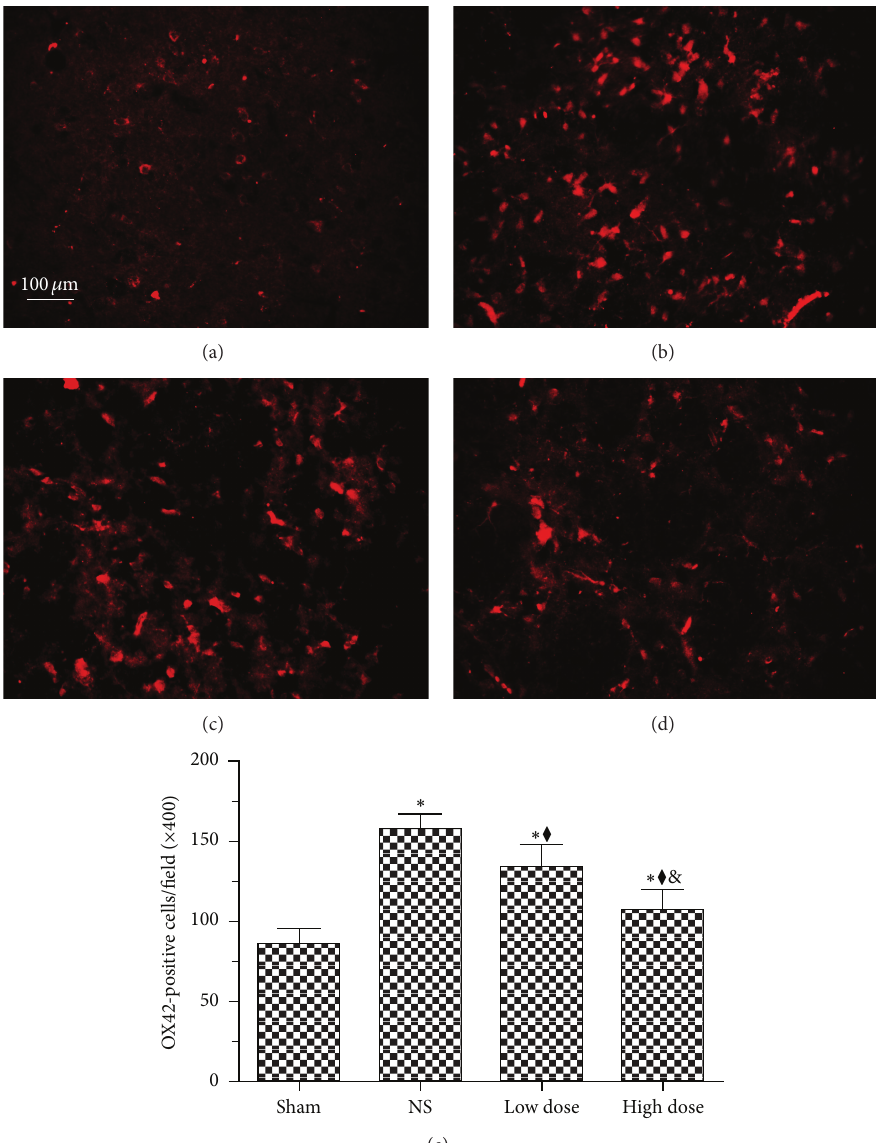
Figure 2: Scutellarin decreases the number of activated microglia in brain of hypertension. (a–d) Cluster of differentiation 11b (OX-42) immunostaining for microglia. (e) Quantification of OX-42-positive cells revealed that activated microglia were significantly increased in normal saline (NS) rats compared with the sham group, and treatment with scutellarin significantly reduced these numbers in a dose- dependent manner. ∗ 𝑃 < 0.001 versus sham group; ⧫ 𝑃 < 0.001 versus NS group; & 𝑃 < 0.001 versus low-dose group. Scale bar = 100 𝜇